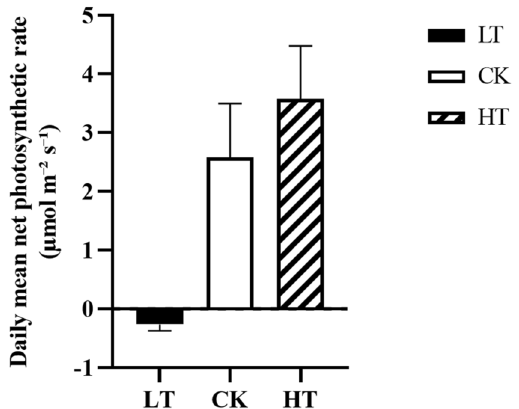
Figure 1. Daily mean net photosynthetic rates ( A ). The columns represent the mean ± SE (n = 5). The letters above the columns indicate significant differences among groups. LT: low temperature treatment group, CK: control group, and HT: high temperature treatment group.